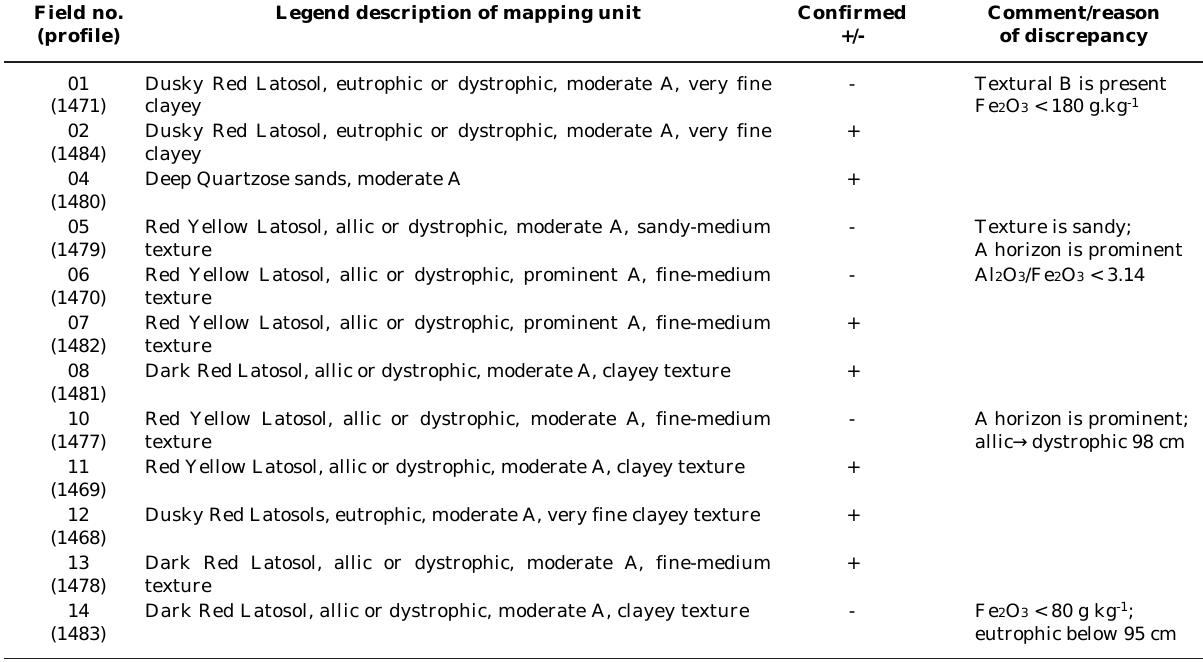
Field no. (profile)